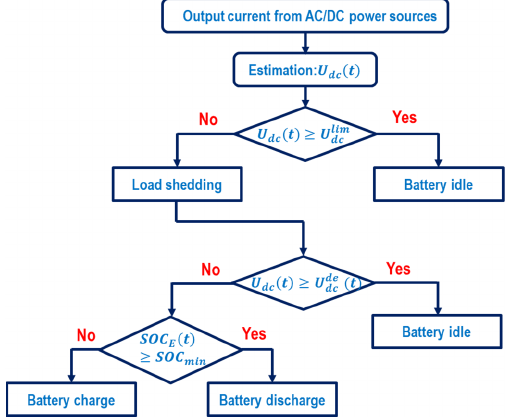
Figure 2 . Proposed control strategy based on voltage ‐ based DR and SBs . Figure 2. Proposed control strategy based on voltage-based DR and